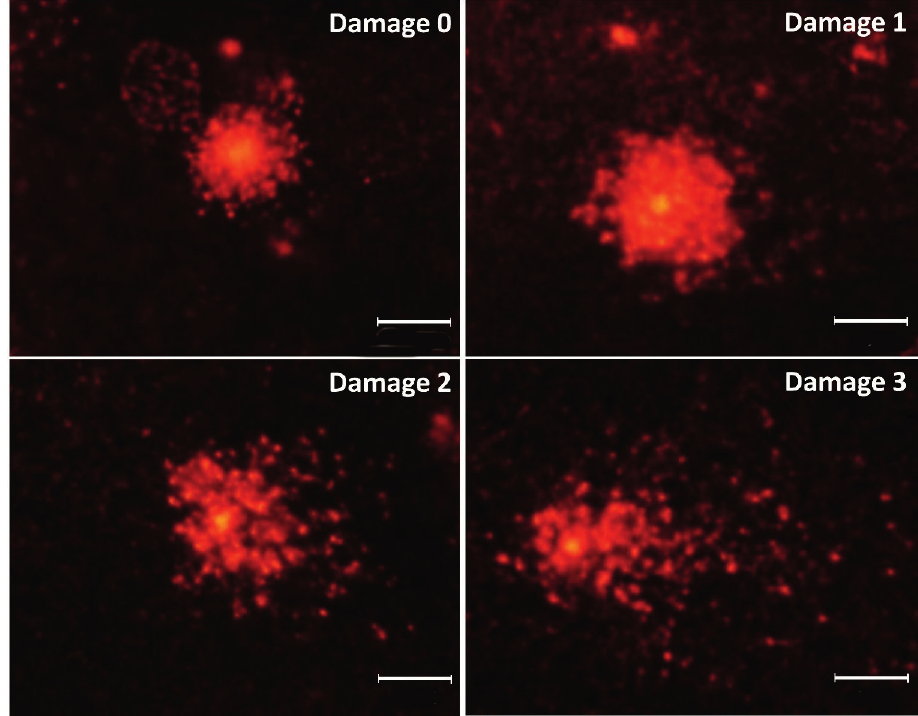
FIGURE 2 | Fluorescence photomicrograph of nuclei with different classes of damage assessed by the Comet Assay analysis: 0, no apparent damage; 1, little damage; 2, average damage; 3, major damage. Scale bars = 95